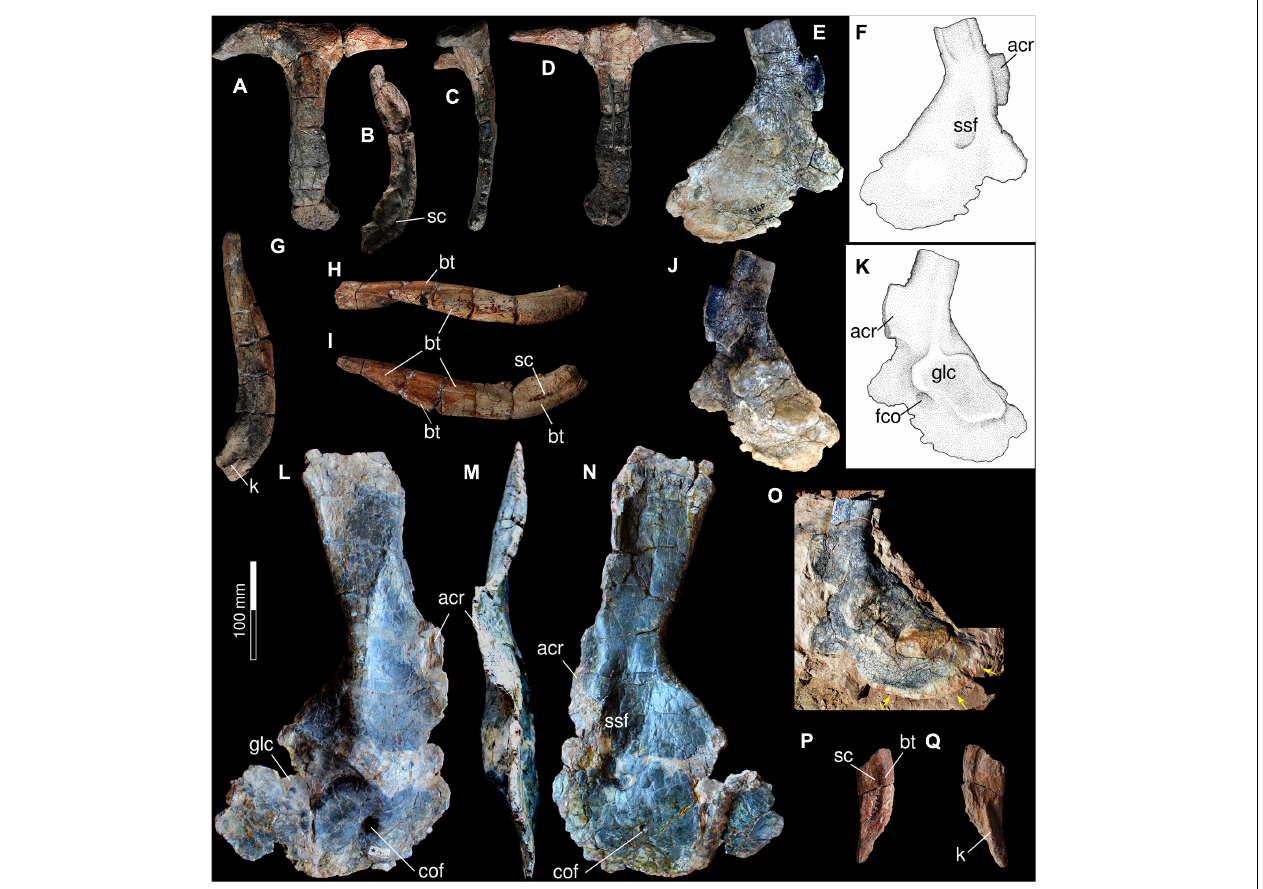
FIGURE 9 | Pectoral girdle of Provelosaurus americanus . UFRGS-PV-0359-P, interclavicle in (A) ventral view, (B) anterior view, (C) right lateral view, (D) dorsal view. (E,F) UFRGS-PV-0376-P, left scapulocoracoid in lateral view. UFRGS-PV-0359-P, right clavicle in (G) posterior (dorsal end to the top of the page), (H) lateral and (I) anterior views. (J,K) UFRGS-PV-0376-P, left scapulocoracoid in medial view. (L–N) UFRGS-PV-0231-P (holotype), right scapulocoracoid in (L) lateral, (M) anterior, and (N) medial view. (O) UFRGS-PV-0376-P, left scapulocoracoid in lateral view, field photograph showing partially ossified margin if posterior coracoid. UFRGS-PV-0359-P, left clavicle medial portion in (P) anterior and (Q) posterior (internal) view. acr, acromion; bt, buttress; cof, coracoid foramen; glc, glenoid cavity; k, keel; sc, sulcus; ssf, subscapular